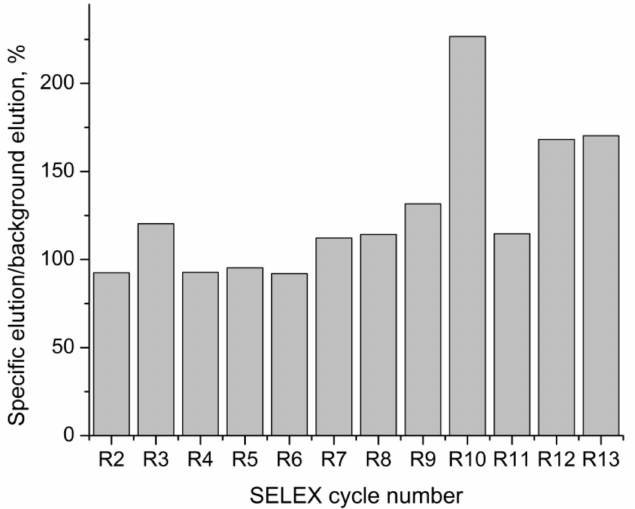
Figure 1. Ratio of the amount of ssDNA eluted by 1 mM furaneol (specific elution) to the amount of ssDNA eluted by the buffer (background elution), during the aptamer selection.